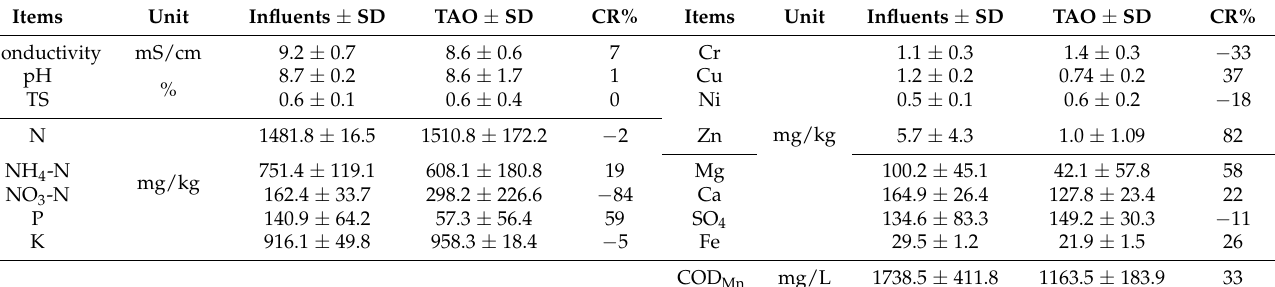
Table 3. Characteristics of the influent and TAO effluent.